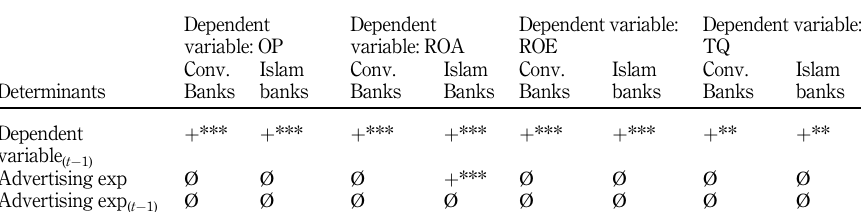
Table 4. Summary of